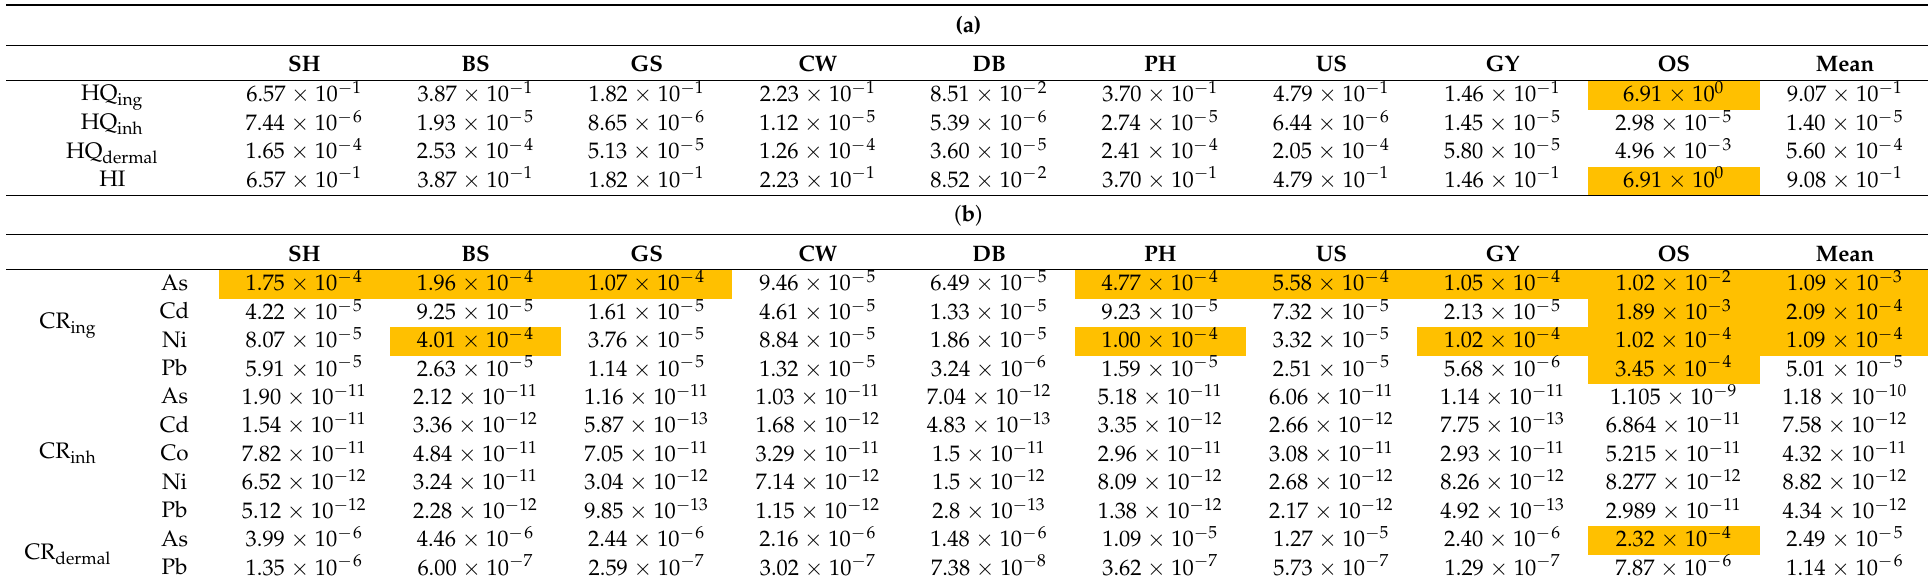
Table 8. Health risk assessment results. ( a ) Non-carcinogenic risks, ( b ) carcinogenic